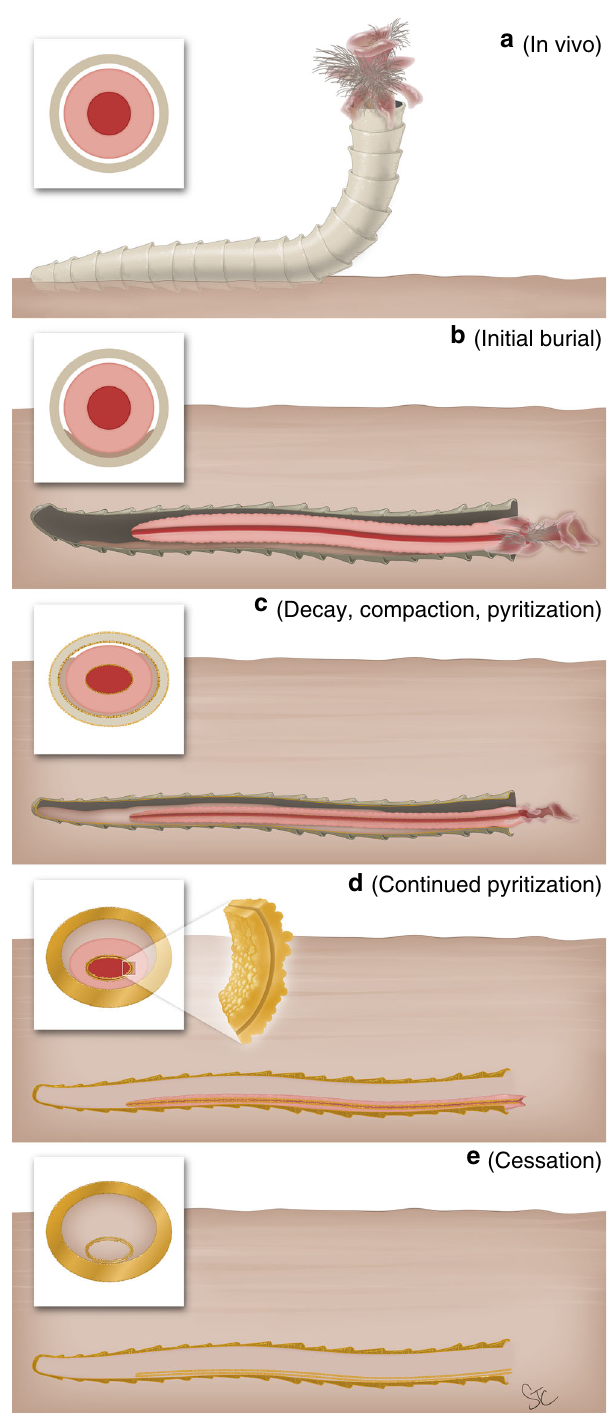
Fig. 7 Proposed taphonomic sequence of the Wood Canyon cloudinomorph soft tissues. a Cloudinomorph in hypothesized life position. External soft tissue hypothesized, modeled after siboglinid polychaete. b Burial by rapid sedimentation and initiation of decay. Sediment begins to enter tube cavity. c Burial compaction of the outer tube from weight of overlying sediment. Early pyritization begins on interior surface of external tube and on both interior and exterior surface of soft-tissue cylinder. d Continued pyritization of exterior tube and soft-tissue cylinder. Inset